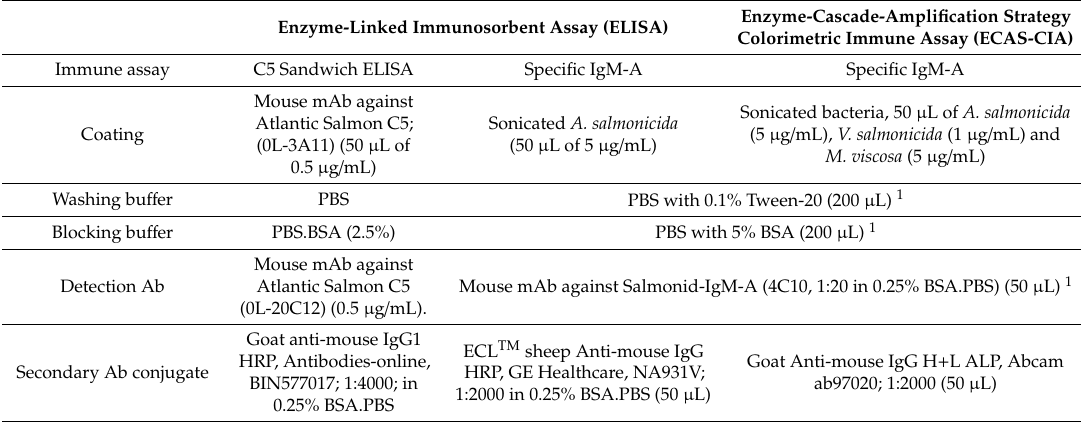
Table 2. Specifications of Enzyme-Linked Immunosorbent Assay (ELISA) and enzyme-cascade- amplification strategy colorimetric immune assay (ECAS-CIA)